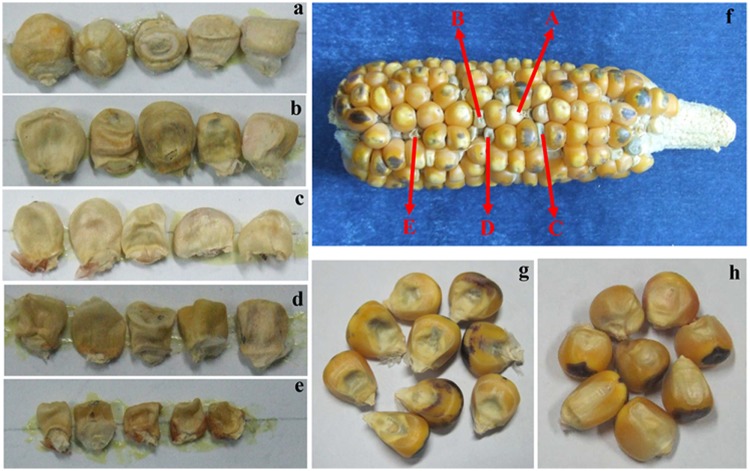
The embryo abortion and different degree of endosperm abortion caused by in vivo haploid induction.(a)1st endosperm aborted kernels (EnA1st), same of the kernel A in Fig 1(f); (b) 2nd endosperm aborted kernels (EnA2nd), same of the kernel B in Fig 1(f); (c) 3rd endosperm aborted kernels (EnA3rd), same of kernel C in Fig 1(f); (d) 4th endosperm aborted kernels (EnA4th), same of kernel D in Fig 1(f); (e) 5th endosperm aborted kernels(EnA5th), same of kernel E in Fig 1(f); (f) F1 ear coming from one plant of Zhengdan958 F2:3 population crossing with inducer CAU5; (g) embryo aborted kernels; (h) haploid kernels.